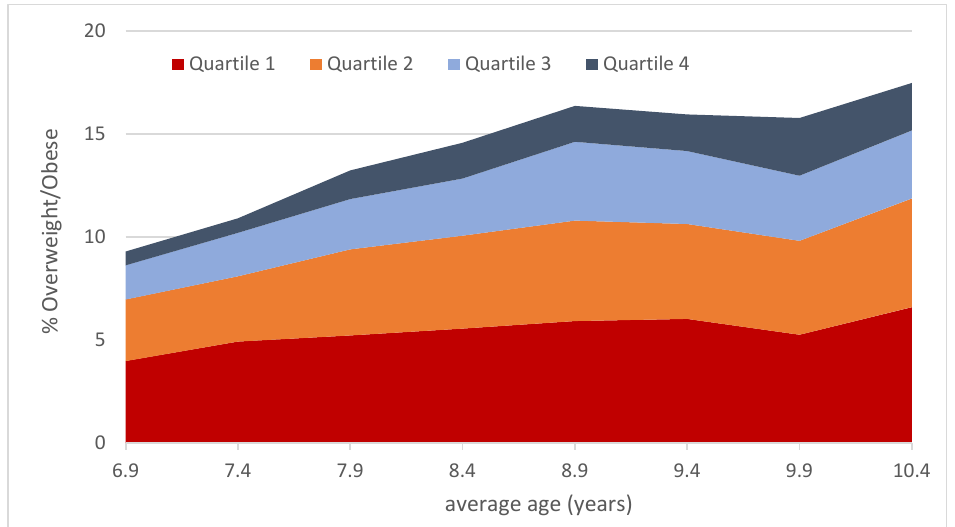
Figure 2. Change in physical fitness across quartiles of baseline BMI percentile (Quartile 1 indicates lowest BMI percentiles). Values are Mean with 95% CI.